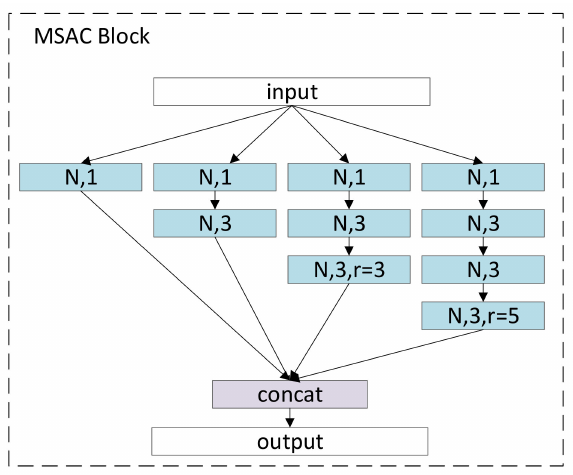
Figure 3. Multiscale atrous convolution block. Where r represents the dilated rate, and N represents the number of